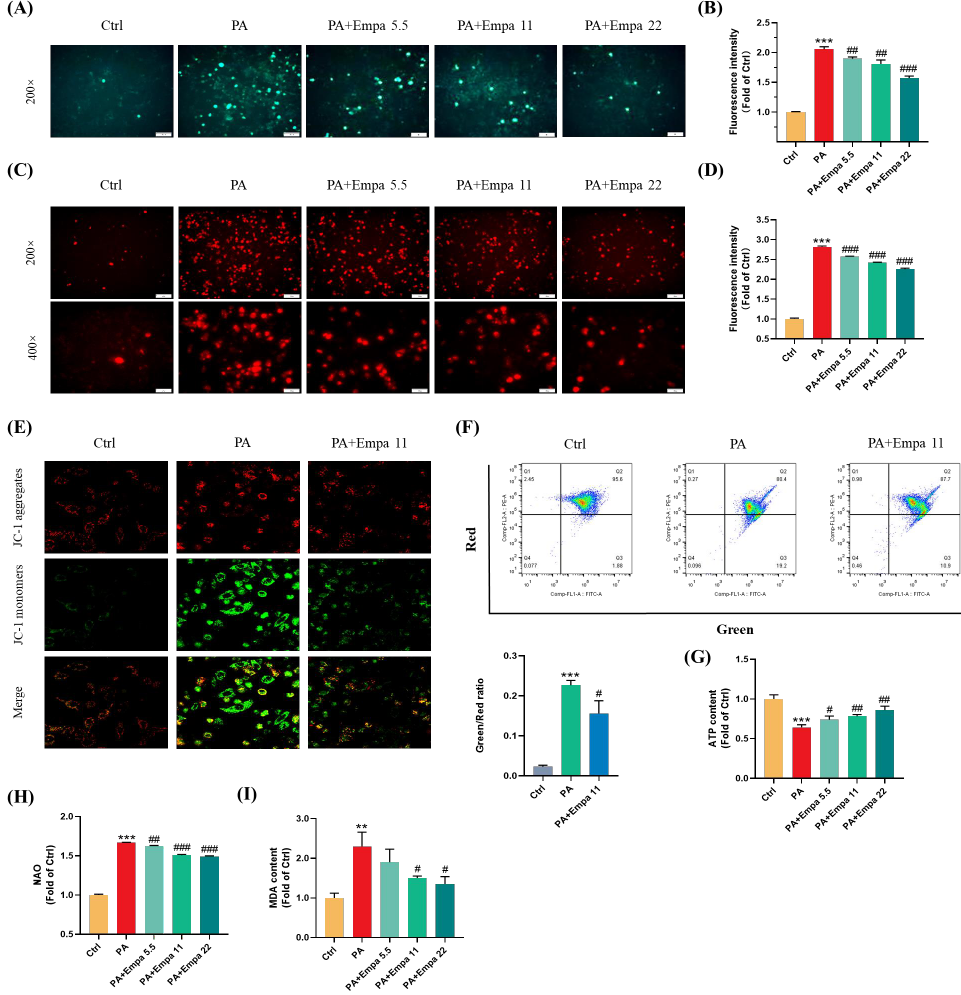
Figure 2. Empa attenuated mitochondrial ROS generation and improved redox homeostasis as well as mitochondrial functions in PA-treated LO2 cells. ( A ) Representative images of intracellular ROS in LO2 cells stained with DCFH-DA. ( B ) Quantification analysis of intracellular ROS. ( C ) Representative images of mitochondria ROS in LO2 cells stained with Mito-SOX. ( D ) Quantification analysis of mitochondrial ROS: cells were treated with 5.5, 11, and 22 μ M Empa and 0.5 mM PA for 24 h. ( E ) Representative confocal microscope images of mitochondrial membrane potential by JC-1 staining. ( F ) Quantification analysis of mitochondrial membrane potential by flow cytometry. ( G ) Empa improved intracellular total ATP content impaired by PA (0.5 mM) in LO2 cells. ( H ) Empa improved mitochondrial division induced by PA (0.5 mM). ( I ) MDA content elevated by PA (0.5 mM) was reversed by Empa (5.5, 11 and 22 μ M). All data are expressed as mean ± SD ( n = 3). ** p < 0.01 and *** p < 0.001 versus Ctrl. # p < 0.05, ## p < 0.01, and ### p < 0.001 versus PA. Ctrl, PA-untreated normal control group; PA, PA-treated control group; PA + Empa 5.5–22, PA-treated and Empa-treated (at final concentrations of 5.5–22 µ M)